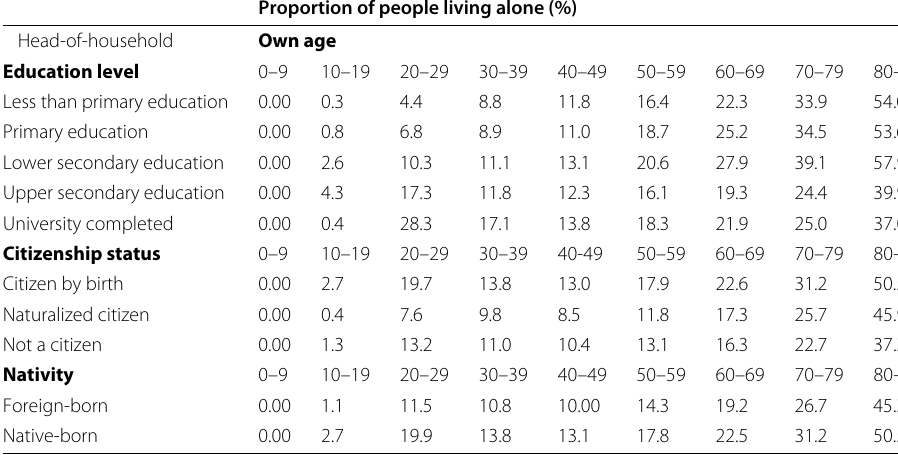
Table 2 Proportion of people living alone by age and head-of-household variables Proportion of people living alone (%)